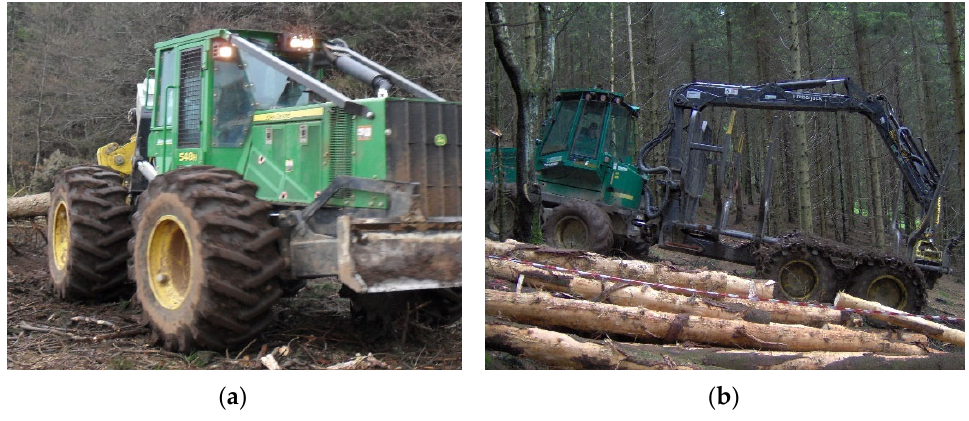
Figure 1. ( a ) Skidder and ( b ) Forwarder used during